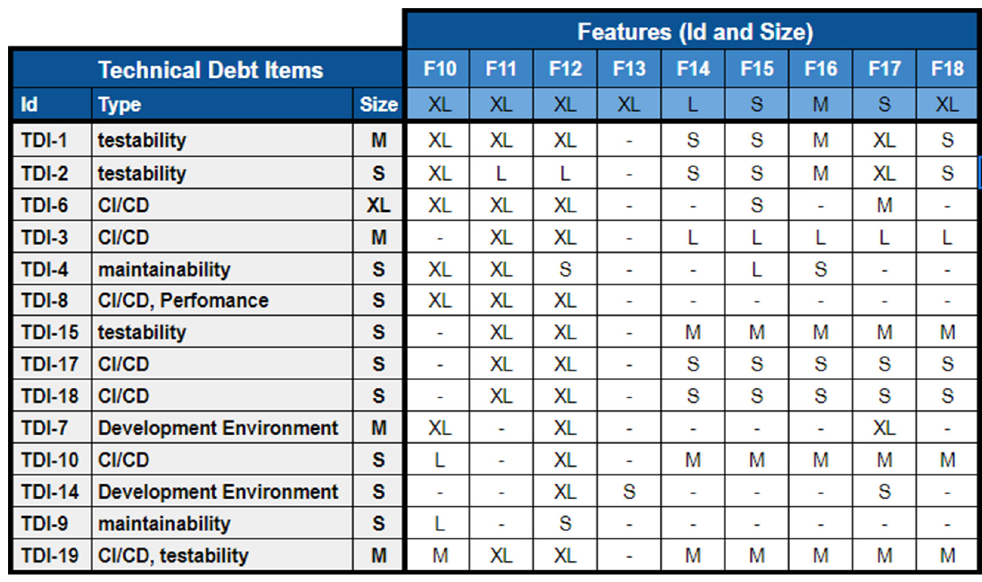
Table 1. Impact of TDIs on feature roadmap.